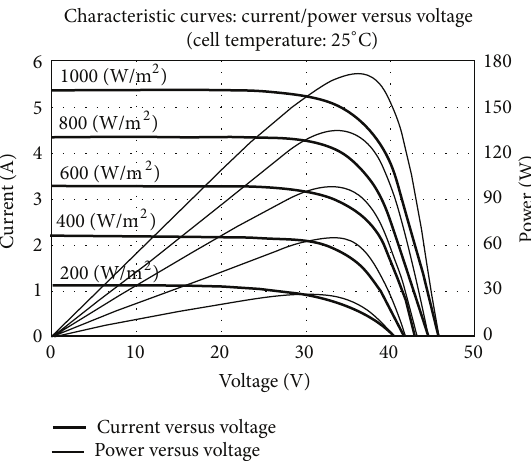
Figure 2: The I-V and P-V curves of the SHARP NT-R5E3E photovoltaic power module datasheet.